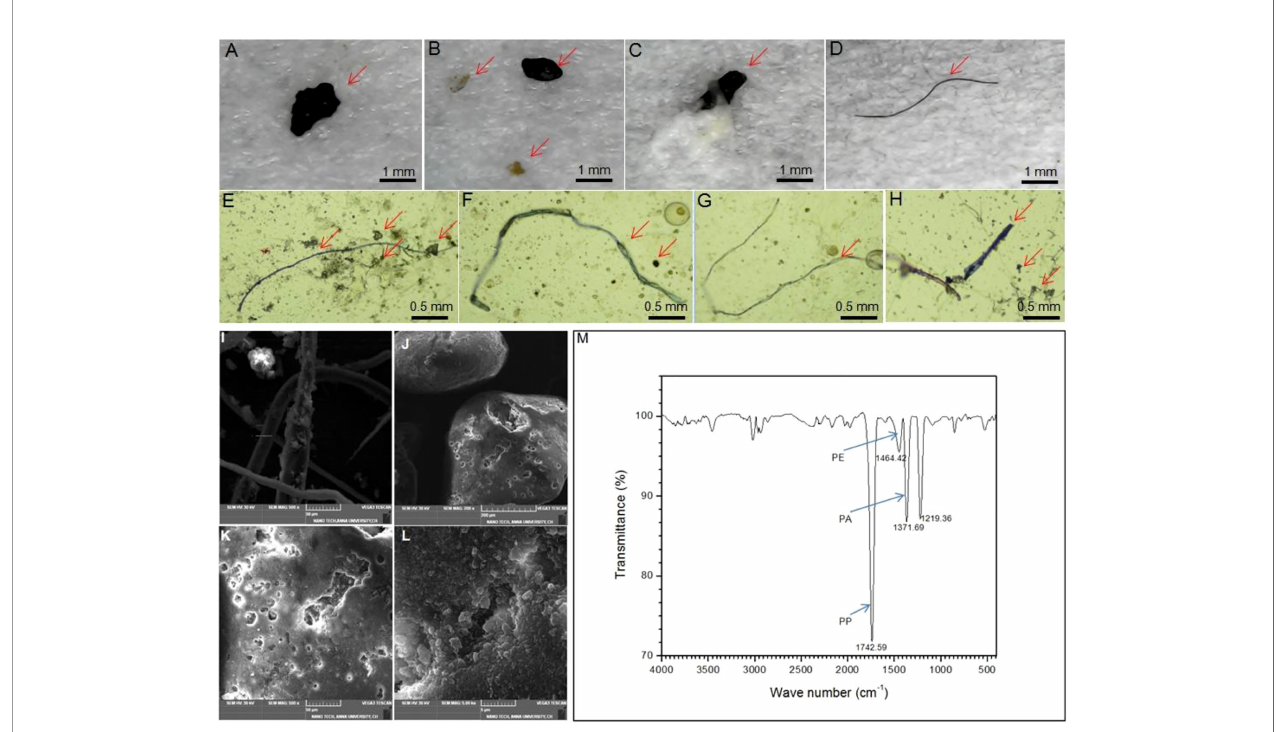
FIGURE 2 | Presence of different types of microplastics in Shark (A – C) Fragments and fi lm (D – H) Fibre and granules (I – L) . SEM images of microplastics (I) Fibre (J , K) Fragment (L) Granules (M) . FTIR spectra representing PE, PA and PP